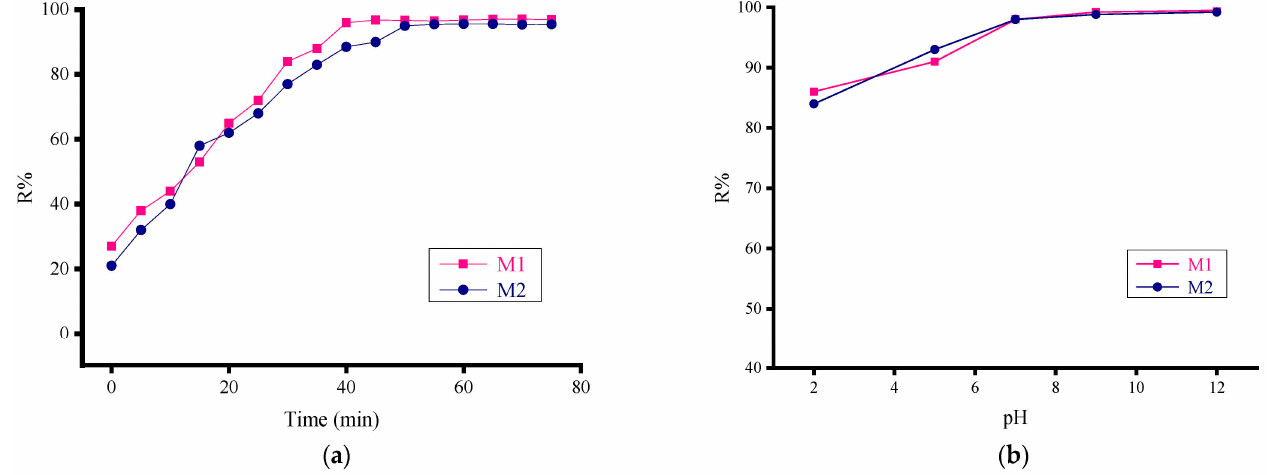
Figure 8. Effect of pH ( a ) and contact time ( b ) on the adsorption of M1 and M2 by the fabricated adsorbent material.